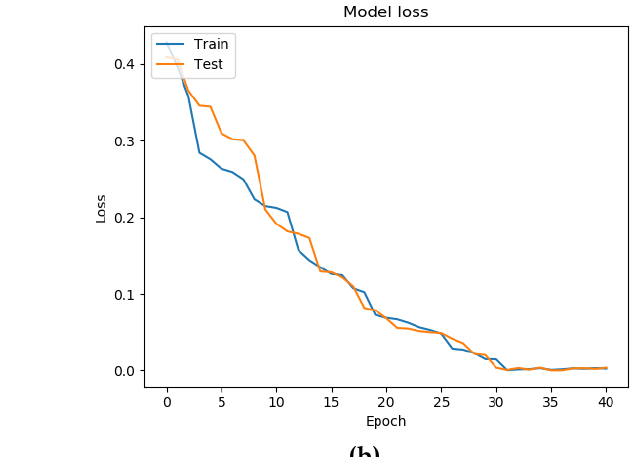
Table 5. Comparative characteristics of neural network architectures for building a general neural network.